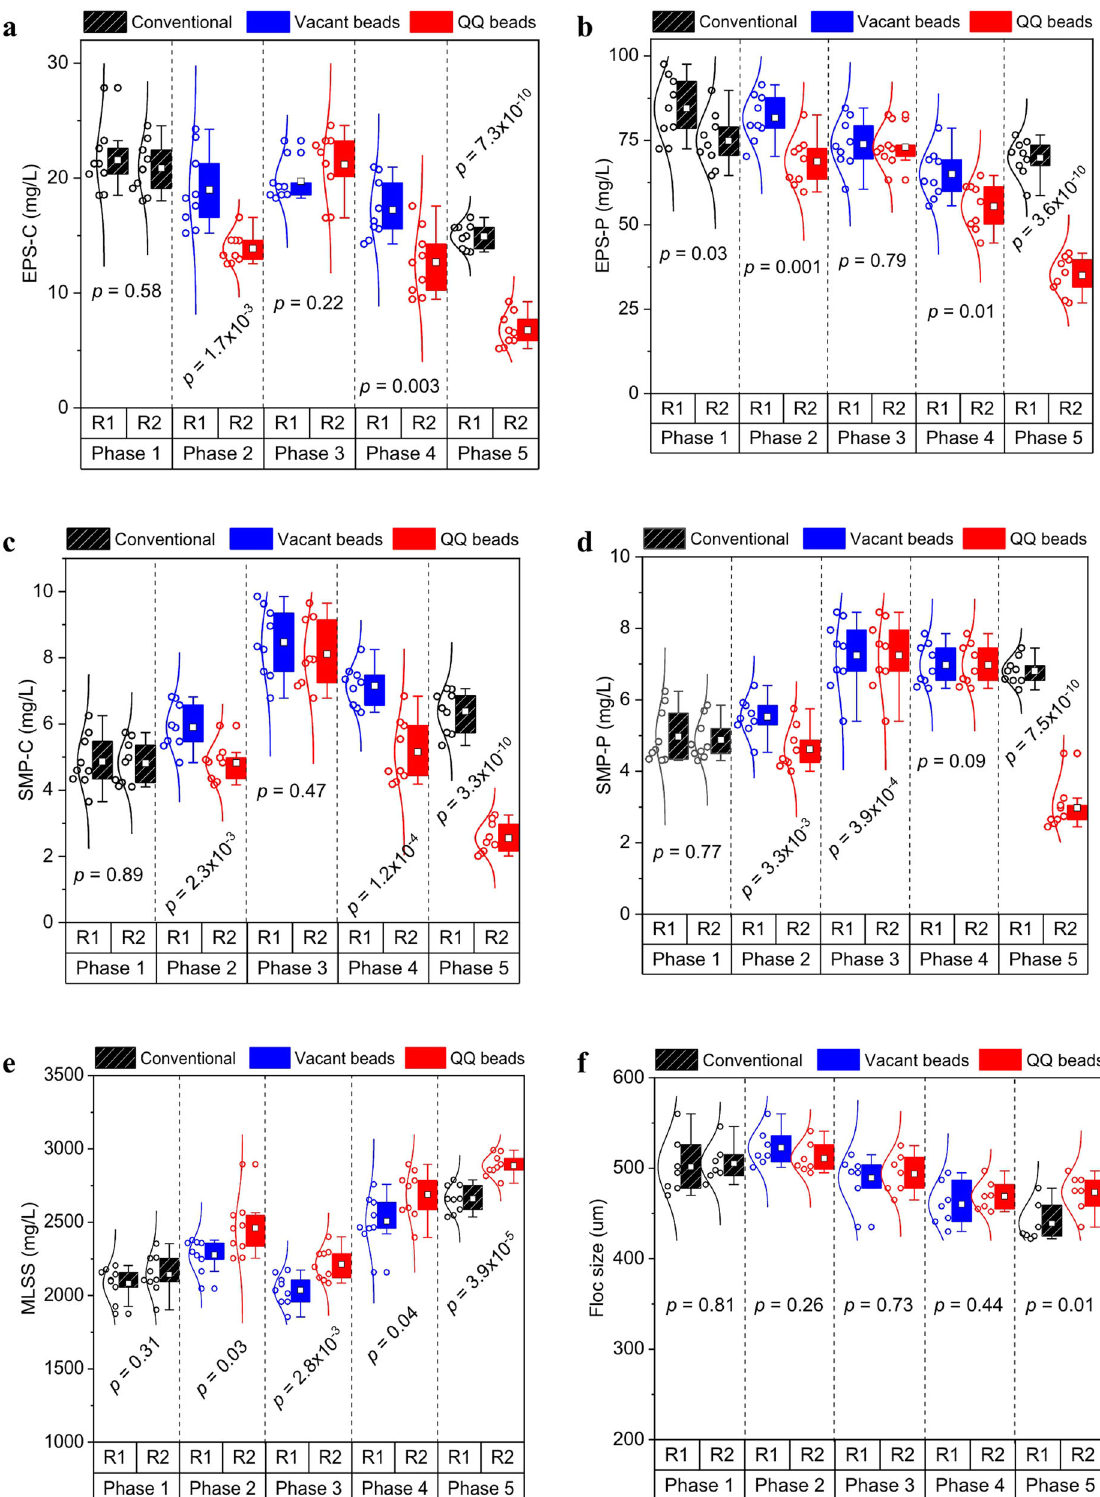
Fig. 2 Biopolymer concentrations and mixed liquor characteristics according to phases in the two MBRs. a EPS-carbohydrates (EPS-C); b EPS-proteins (EPS-P); c SMP-carbohydrates (SMP-C); d SMP-proteins (SMP-P); e mixed liquor suspended solids (MLSS); and f fl oc size. The box is determined by the 25th and 75th percentiles, whereas the whiskers are determined by the 5th and 95th percentiles. The white square symbol inside each bar represents the average value of each